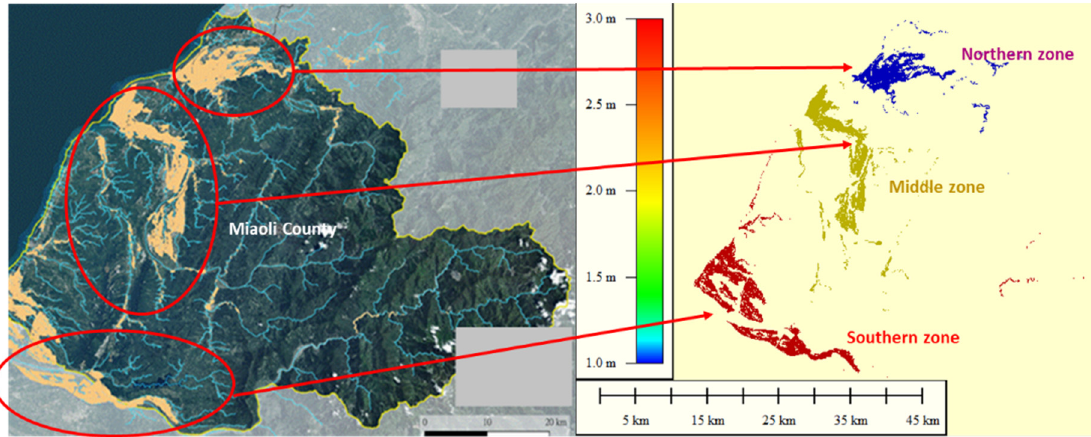
Figure 11. Potential inundation zones within Miaoli County.